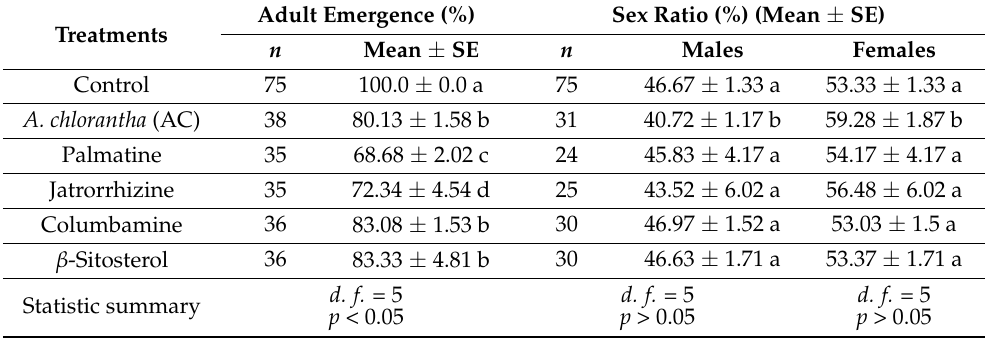
Table 2. Effect of tested LC 50 concentrations of palmatine, jatrorrhizine, columbamine, β - sitosterol, and Annickia chlorantha extract (AC) on the adult emergence and sex ratio percentages of the mosquito, Culex pipiens.